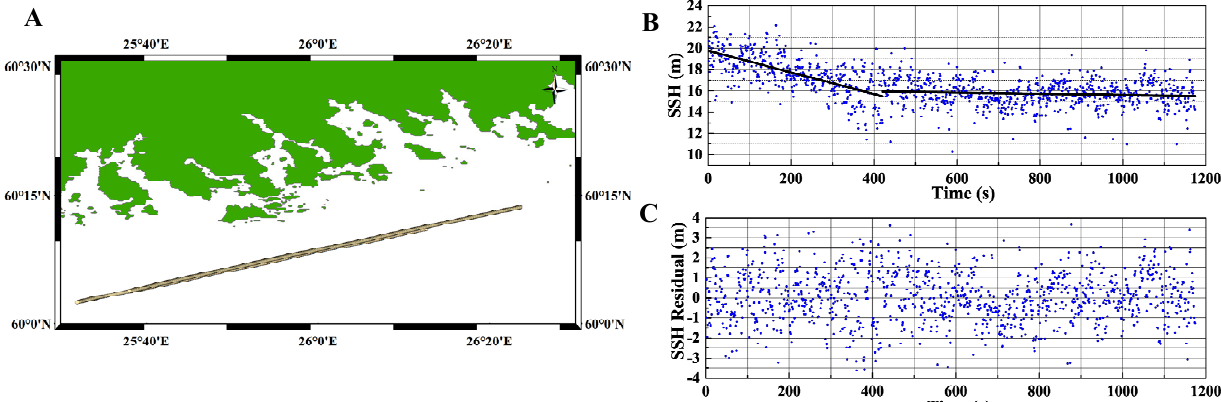
Figure 4. Experimental area and IF data processing results. ( A ) The specular points tracks of the raw IF data. ( B ) Measured SSH relative to the WGS84 reference ellipsoid. ( C ) SSH residual after subtracting the fitted value.